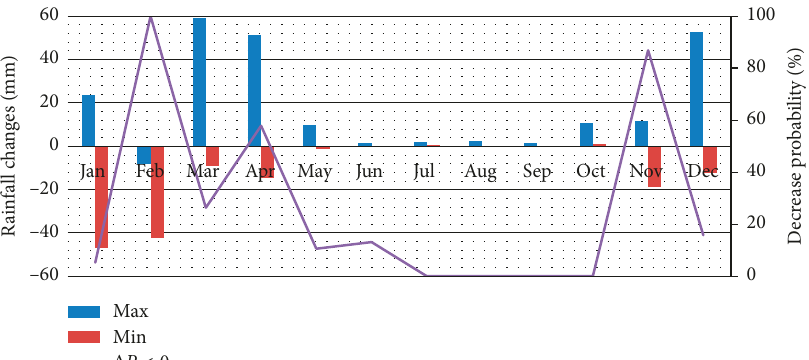
Figure 8: Range of changes in the monthly rainfall in the future middle period under all models and three emission scenarios and their probabilities.